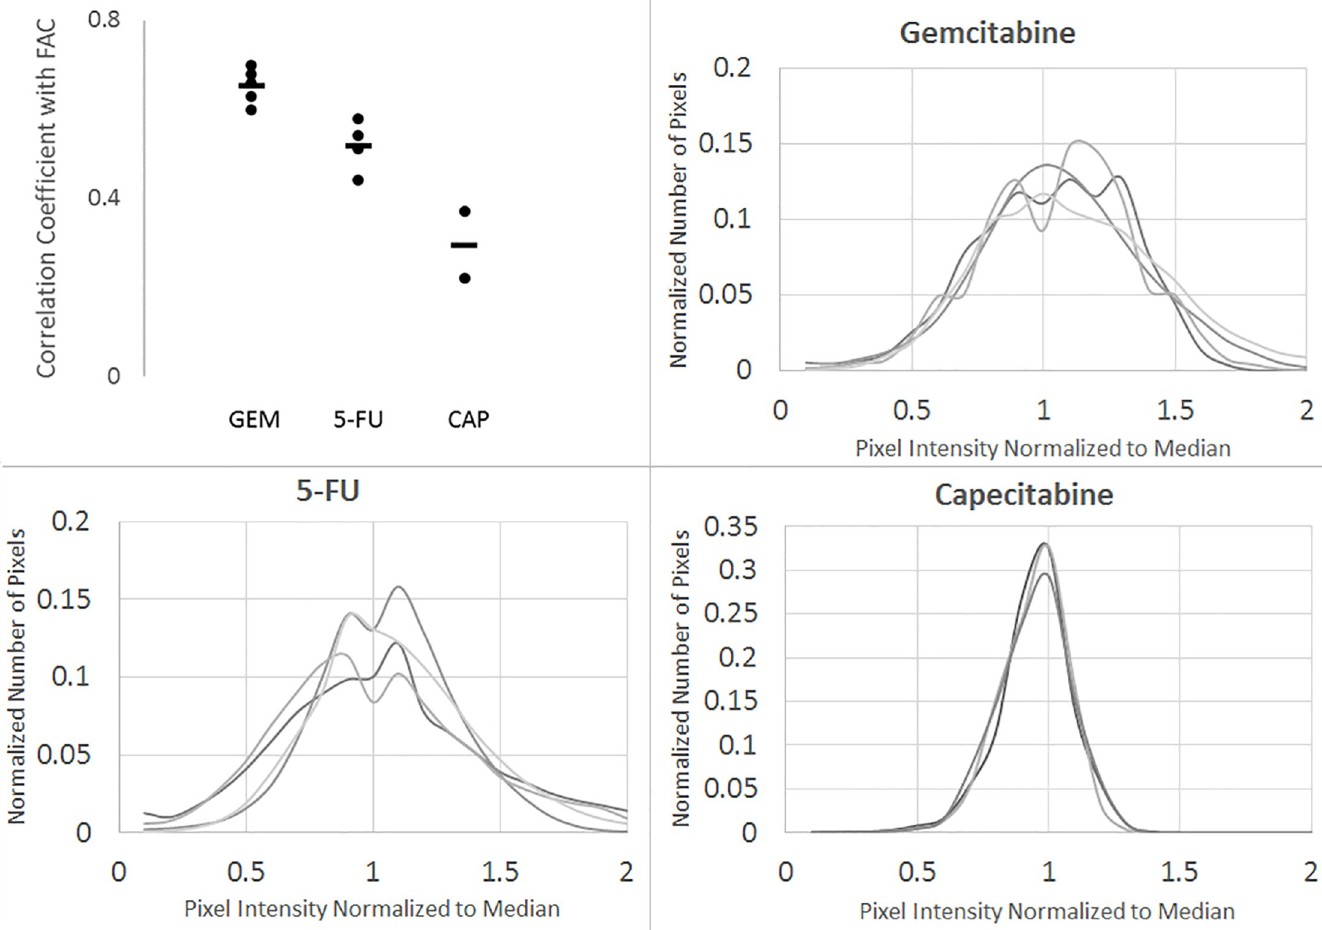
Fig 6. Comparison of gemcitabine, 5-FU and capecitabine drug distribution. (A) Dots show the correlation coefficient of pixels values for FAC/GEM (n = 4), FAC/ 5-FU (n = 4), and FAC/CAP (n = 3) autoradiography. Lines show the mean value. Histograms of the Gemcitabine (B), 5-FU (C) and Capecitabine (D) activity distribution in the non-necrotic portions of the